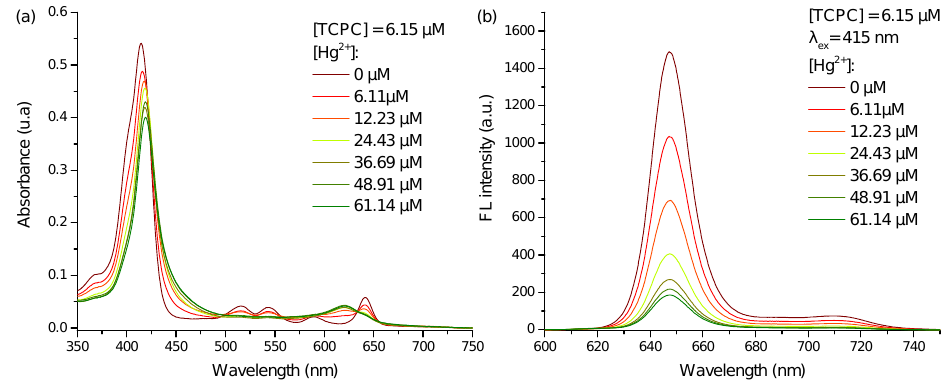
Figure 3. Absorbance ( a ) and fluorescence ( λ ex = 415 nm) ( b ) spectra of TCPC aqueous solutions at pH 7.4 with different concentrations of Hg 2+